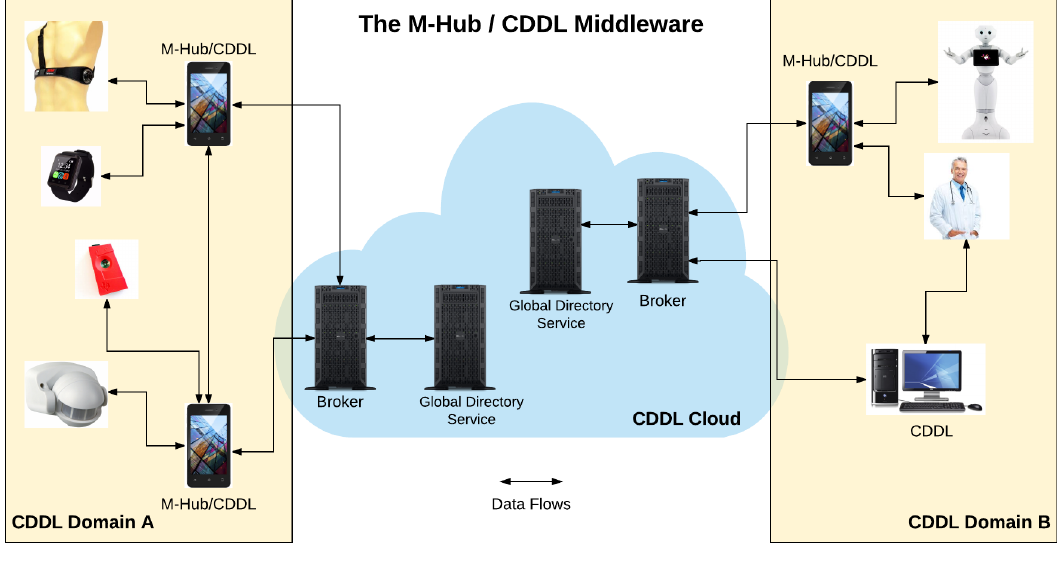
Figure 1. M-Hub/CDDL Infrastructure